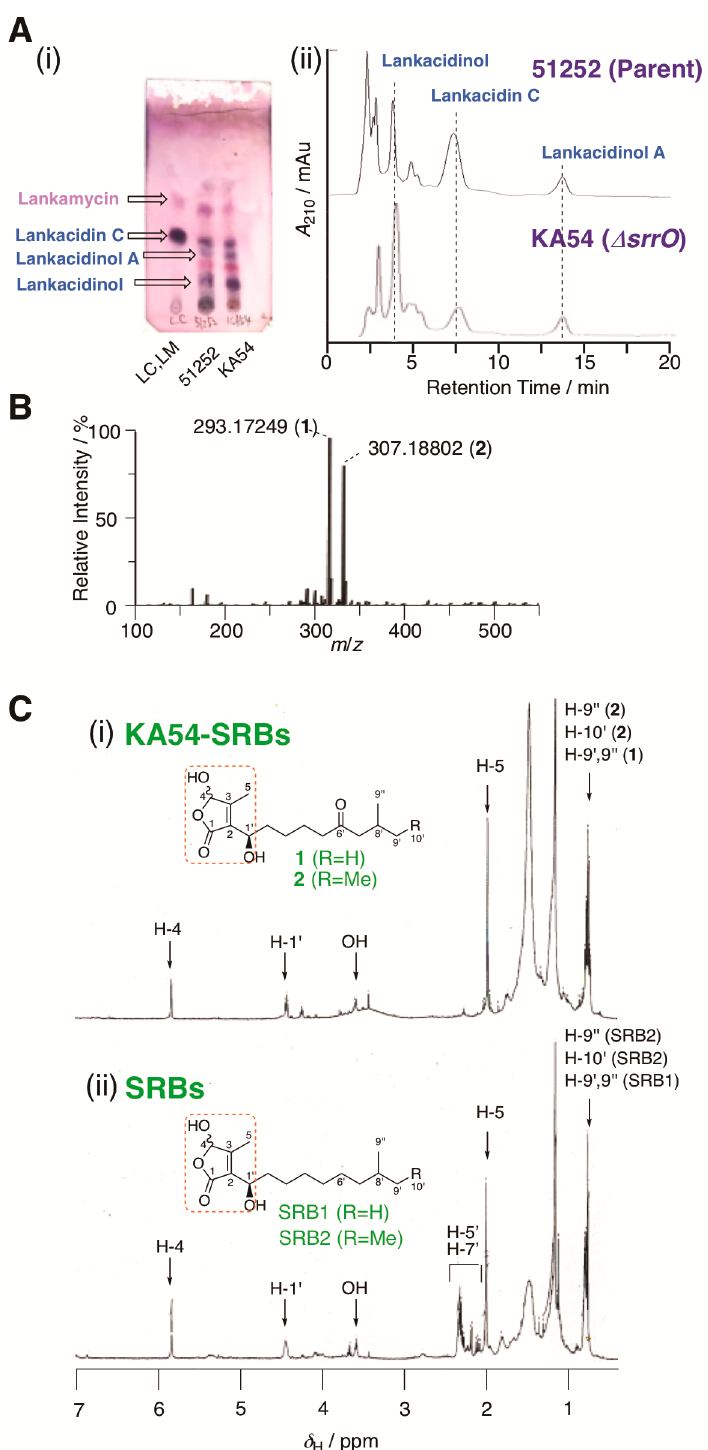
Figure 2. Metabolite analysis of strain KA54. ( A ) ( i ) TLC analysis of metabolites in strains KA54 ( srrO mutant) and 51252 (parent). LC; standard sample of lankacidin C. ( ii ) HPLC analysis of metabolites in strains KA54 and 51252. Chromatogram was monitored by UV absorbance at 230 nm. Structures of lankacidin C and lankamycin were displayed in Supplementary Figure S1. ( B ) ESI-MS spectrum of KA54-SRBs ( 1 and 2 ). ( C ) 1 H NMR spectrum of ( i ) KA54-SRBs ( 1 and 2 ) and ( ii ) SRBs. Compound 1 (KA54-SRB1): high resolution ESI-MS; observed m / z 293.1727 [M + Na] C 15 H 26 O 4 Na,